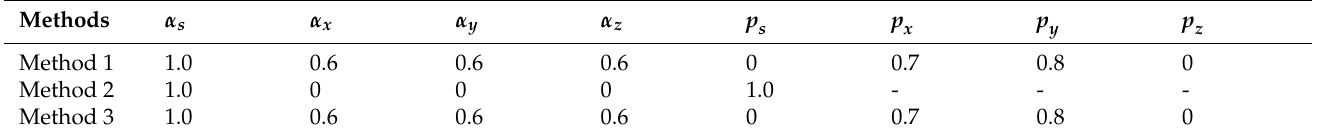
Table 4. Regularization term coefficients and p values for the sparsity norms.